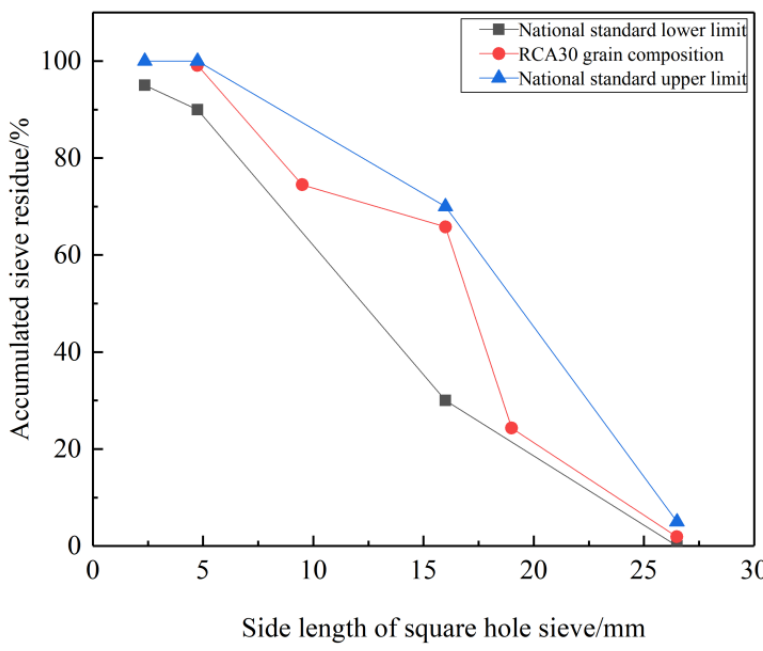
Figure 2, which meets the requirements of RCA quality evaluation standard (GB/T25177- 2010). Among them, the cement used in the original concrete is ordinary Portland cement Table 1. The original concrete mixture ratio. of P.O. 42.5 grade of Shanshui Group, the coarse aggregate is granite macadam with the grain size of 5–25 mm, the fine aggregate is river sand produced in Pingdu, Qingdao with fineness modulus of 2.5, the water reducing agent is polycarboxylate superplasticizer with water reducing rate of 25%. The mixing ratio of the original concrete and the compressive strength of the 28 d cube are shown in Table 1.